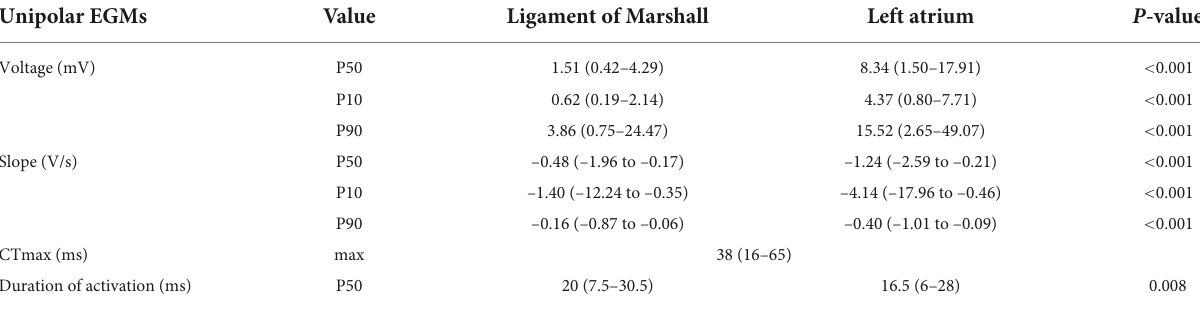
TABLE 2 Characteristics of unipolar EGMs.